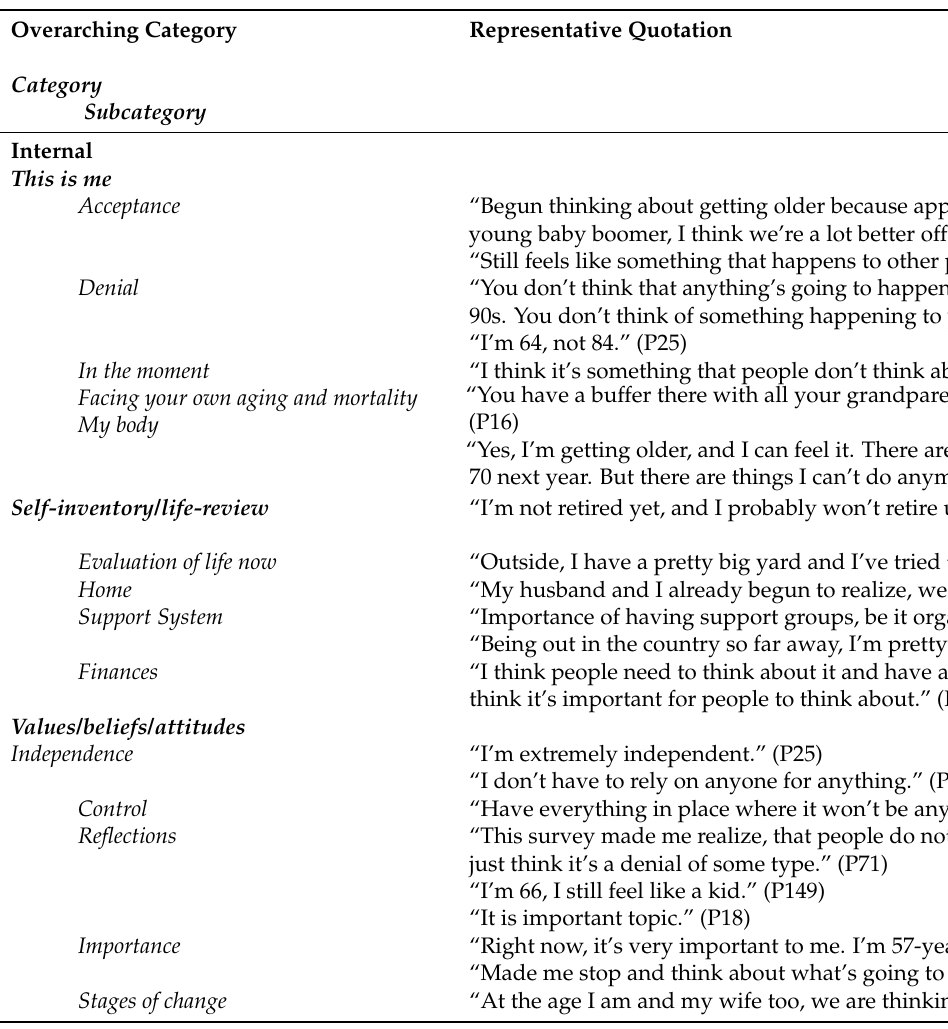
Table 2. Categories and subcategories with representative quotations of